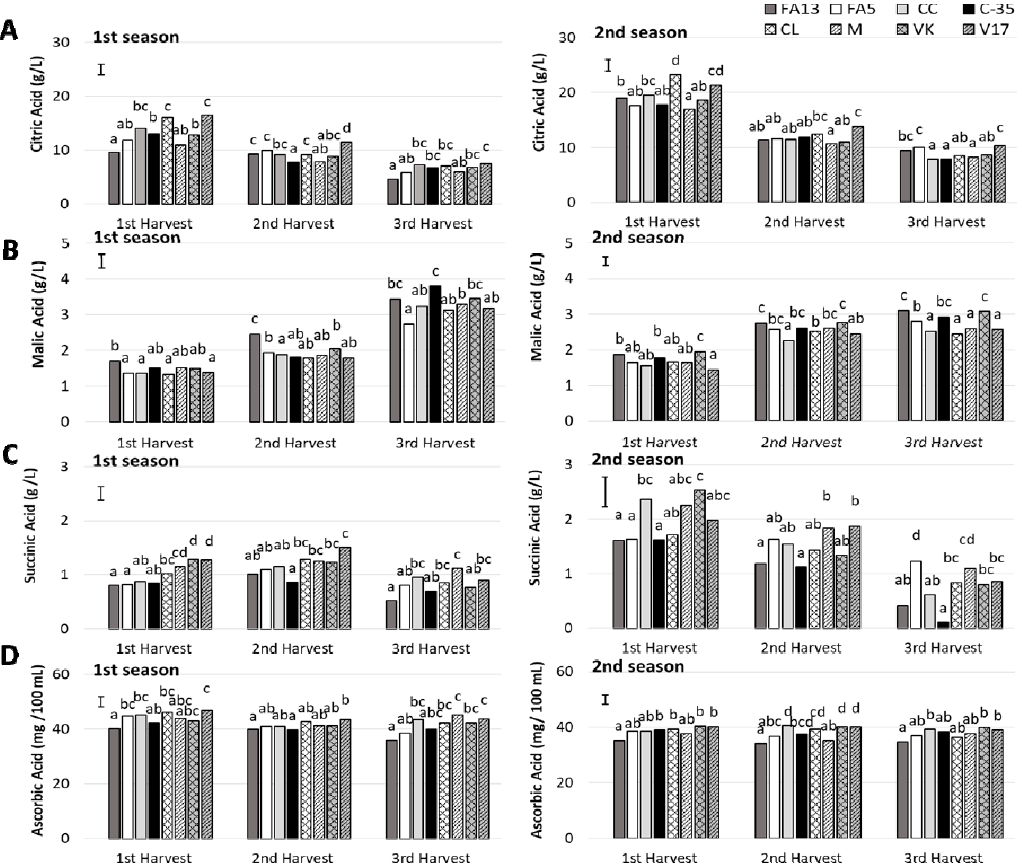
Figure 4. Organic acids ( A : citric; B : malic; C : succinic) and vitamin C ( D : ascorbic acid) of the ‘Clemenules’ mandarin grafted onto the eight studied rootstocks at three harvest times during two seasons. Vertical bar in each season represents the least significant difference (LSD) intervals ( p ≤ 0.05) (interaction harvest-rootstock). Different letters above bars indicate significant differences among rootstocks at each harvest time ( p ≤ 0.05).